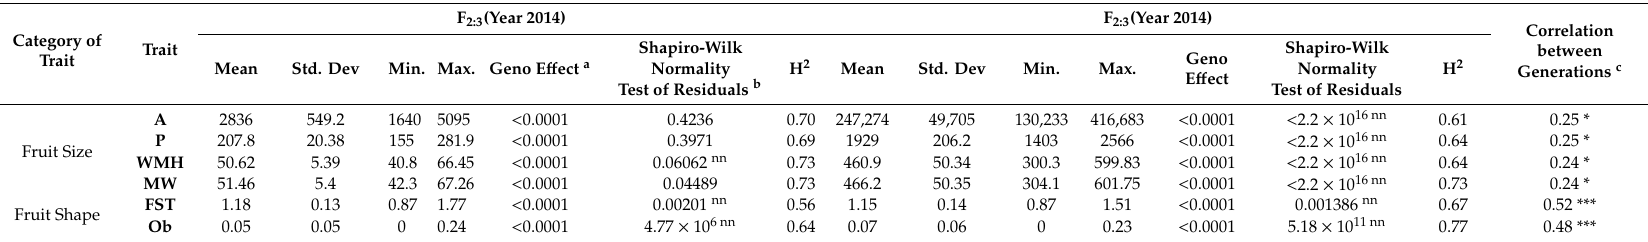
Table 1. Descriptive statistics for fruit morphological attributes measured by Tomato Analyzer (TA) in two generations (F 2:3 and F 5:6 ), significance test of genotypic e ff ects on the attributes measured, normality test of residuals, broad-sense heritability (H 2 ) and the correlation coe ffi cients between generations in the intra-specific population NC 10204 of tomato.